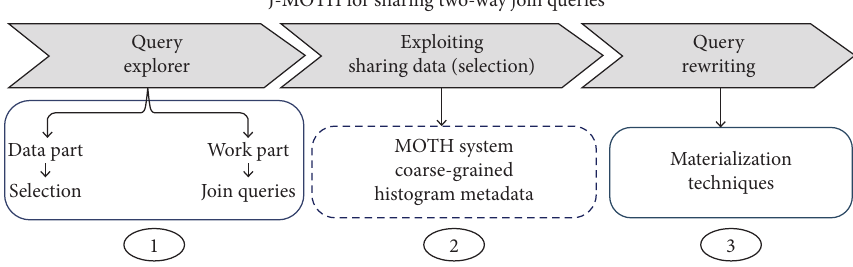
Figure 4: The J-MOTH system phases for two-way join optimization.